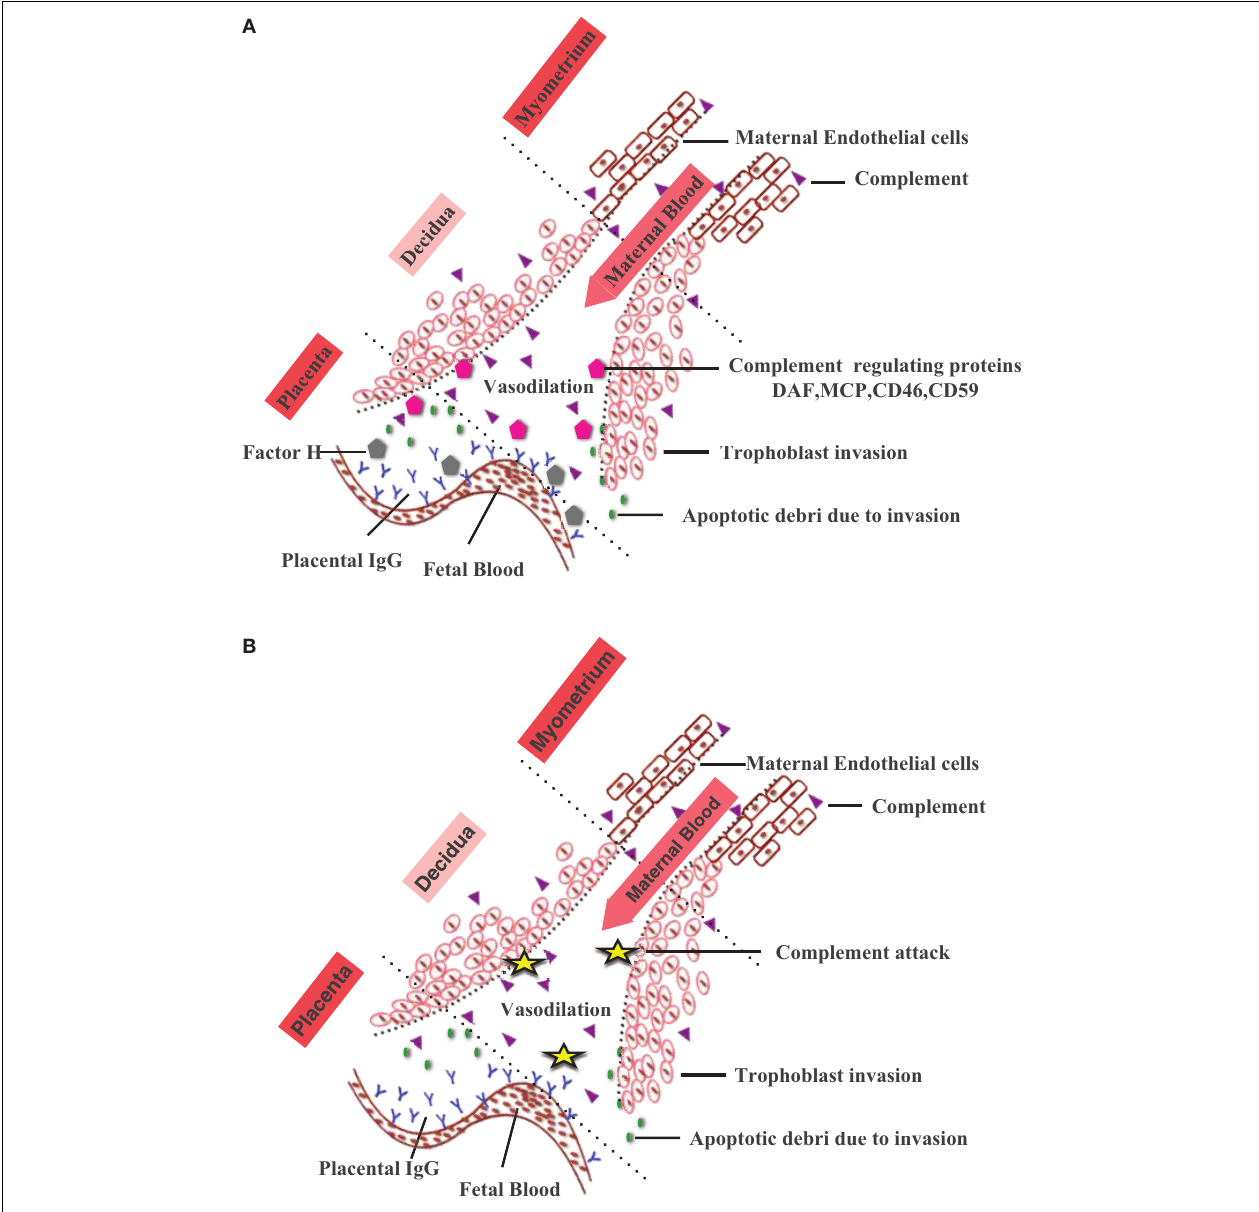
apoptotic cells, complement system protects the mother and fetus. Complement regulatory proteins found on human placental tissues such as Factor H, DAF, MCP, CD46, and CD59 prevent excessive complement activation. (B) In the absence of regulatory proteins (DAF, MCP, CD46, CD59), excessive complement activation results in improper placentation, characterized by increased ROS, inflammatory cytokines, angiogenic proteins (accumulation of apoptotic cells), improper vascularization, and spiral artery remodeling contributing to development of pathological/complicated